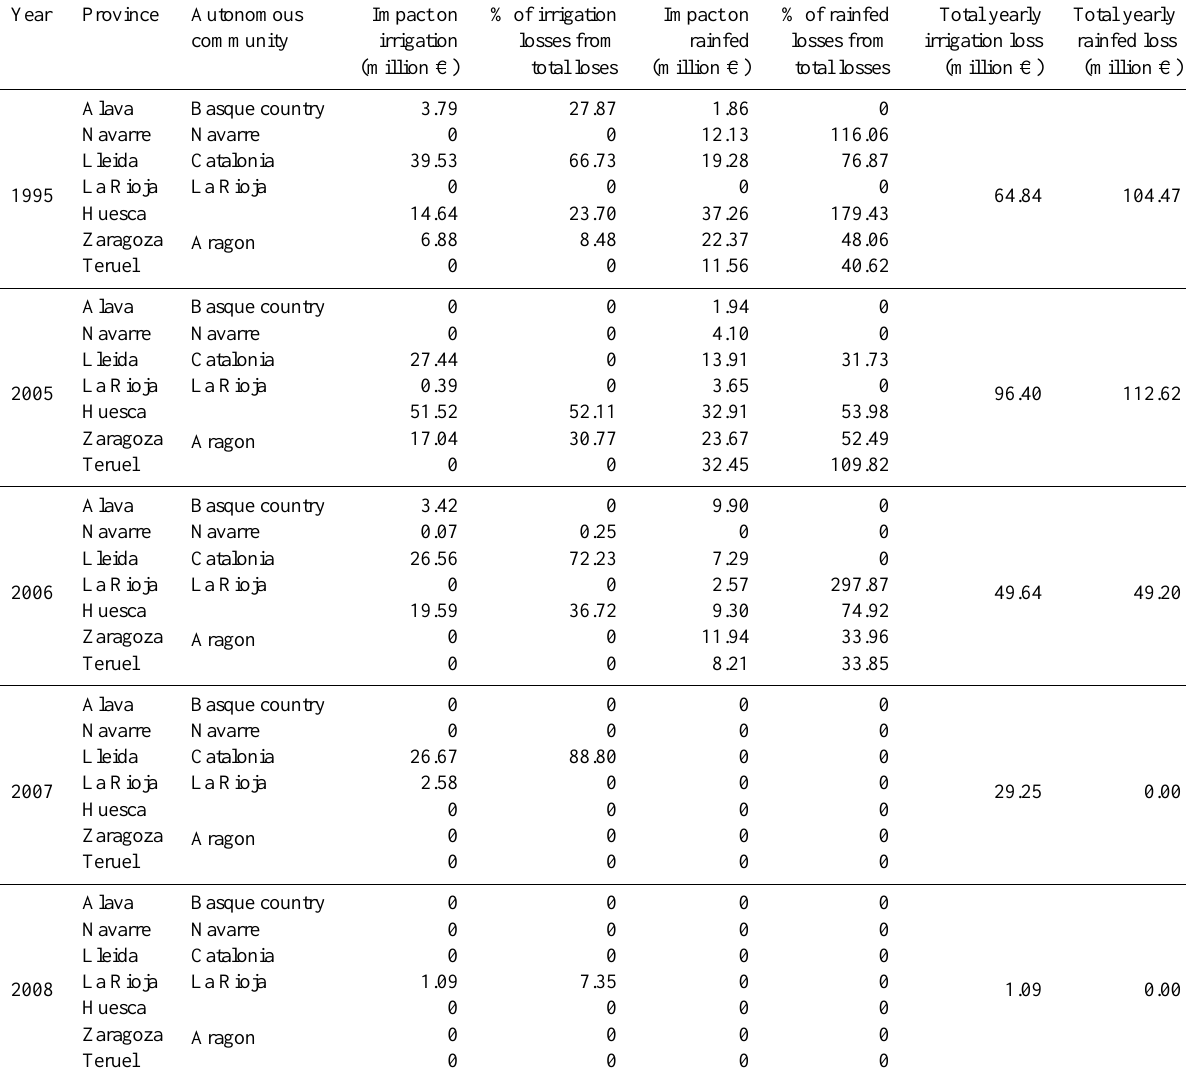
Table 5. 2005–2008 direct impacts, percentage of the total decrease in the value of production attributable to water